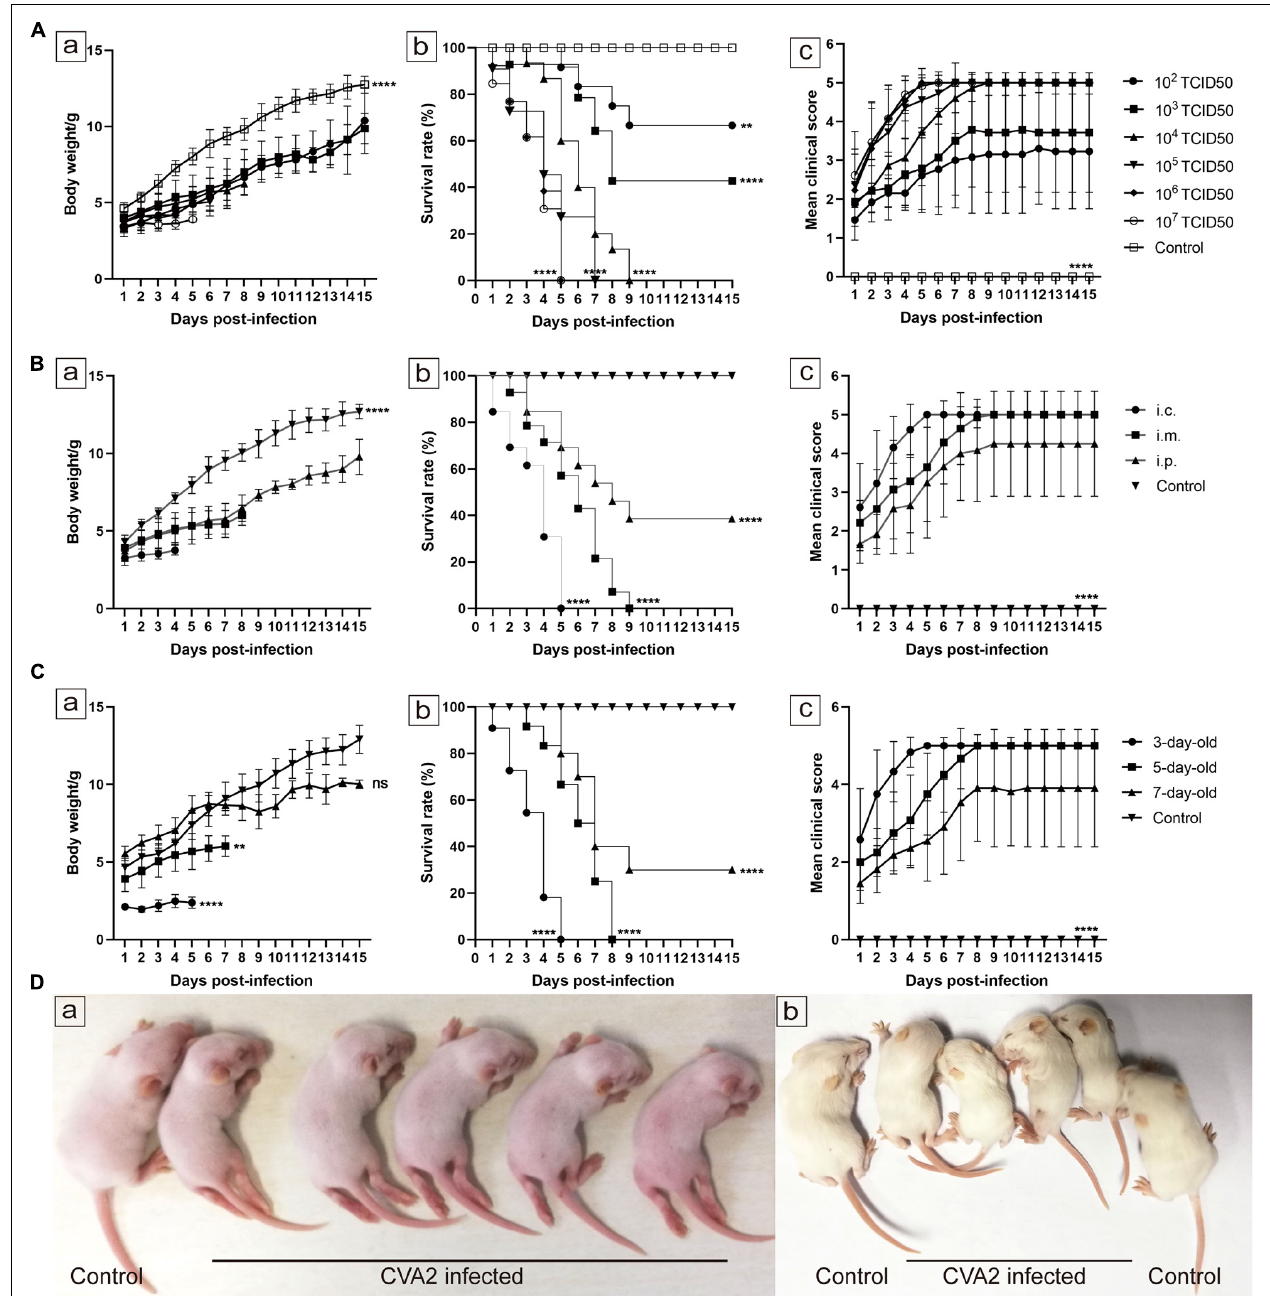
FIGURE 2 | Establishment of the CVA2 infection mouse model. (A–C) Body weights, survival rates, and mean clinical scores of mice. Five-day-old BALB/c mice ( n = 10 ∼ 15 per group) were i.m. inoculated with different doses of CVA2 (10 2 ∼ 10 7 TCID 50 /mouse, respectively). Control animals were administered culture medium instead of virus. The body weights (A-a,B-a,C-a) , survival rates (A-b,B-b,C-b) , and clinical scores (A-c,B-c,C-c) in each group of neonatal mice were measured. (D) Two representative pictures of clinical signs (weight loss, reduced mobility, ataxia, and single or double hind limb paralysis) induced by CVA2 in mice. a. 5 dpi and b. 7 dpi. ** P < 0.01; **** P < 0.0001; ns, non-significant